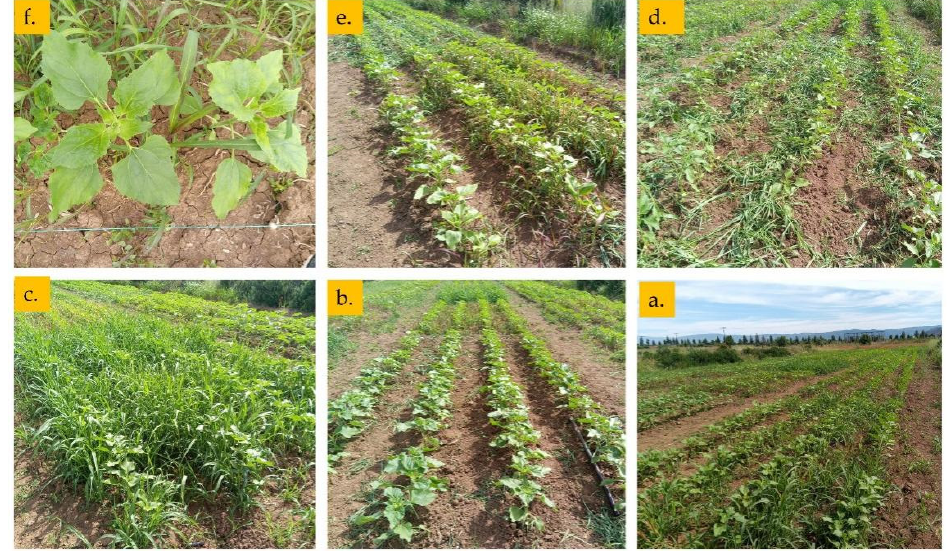
Figure 6. ( a ) Experimental field at 30 DAS (days after sowing) in 2019. ( b ) Weed free plot. ( c ) Weed infested plot. ( d ) Weed infested for 30 DAS plot. ( e ) Fluazifop-p-butyl plot. ( f ) Chlorosis on sun- flower leaves at